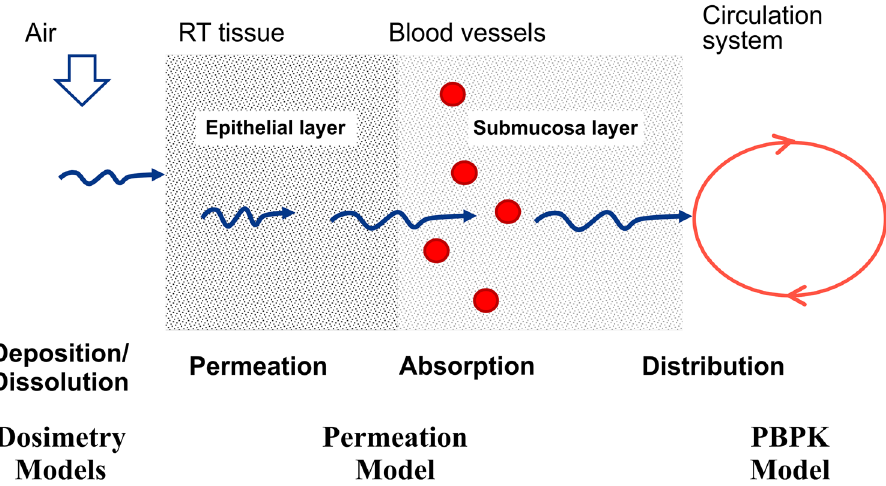
Figure 1. Nicotine transport process from RT airway to circulation system including permeation through RT